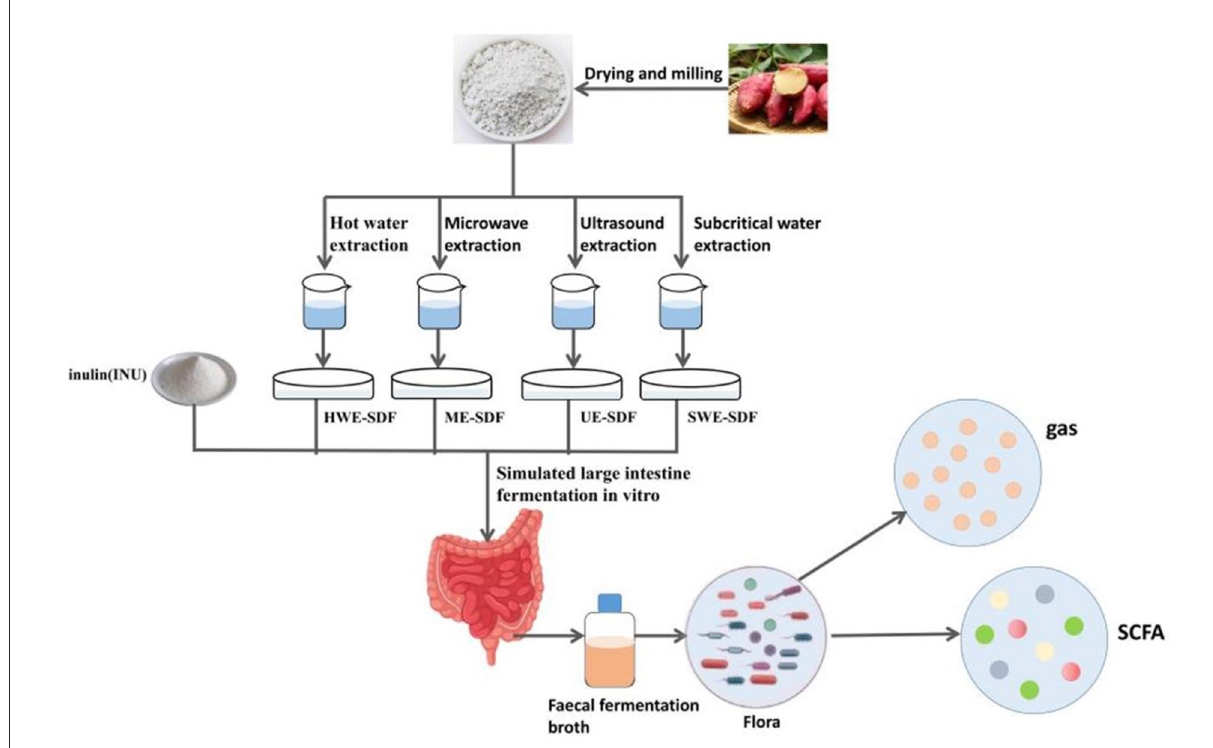
FIGURE1 The schematic chart of extracting dietary fiber from sweet potato peels and simulating intestinal